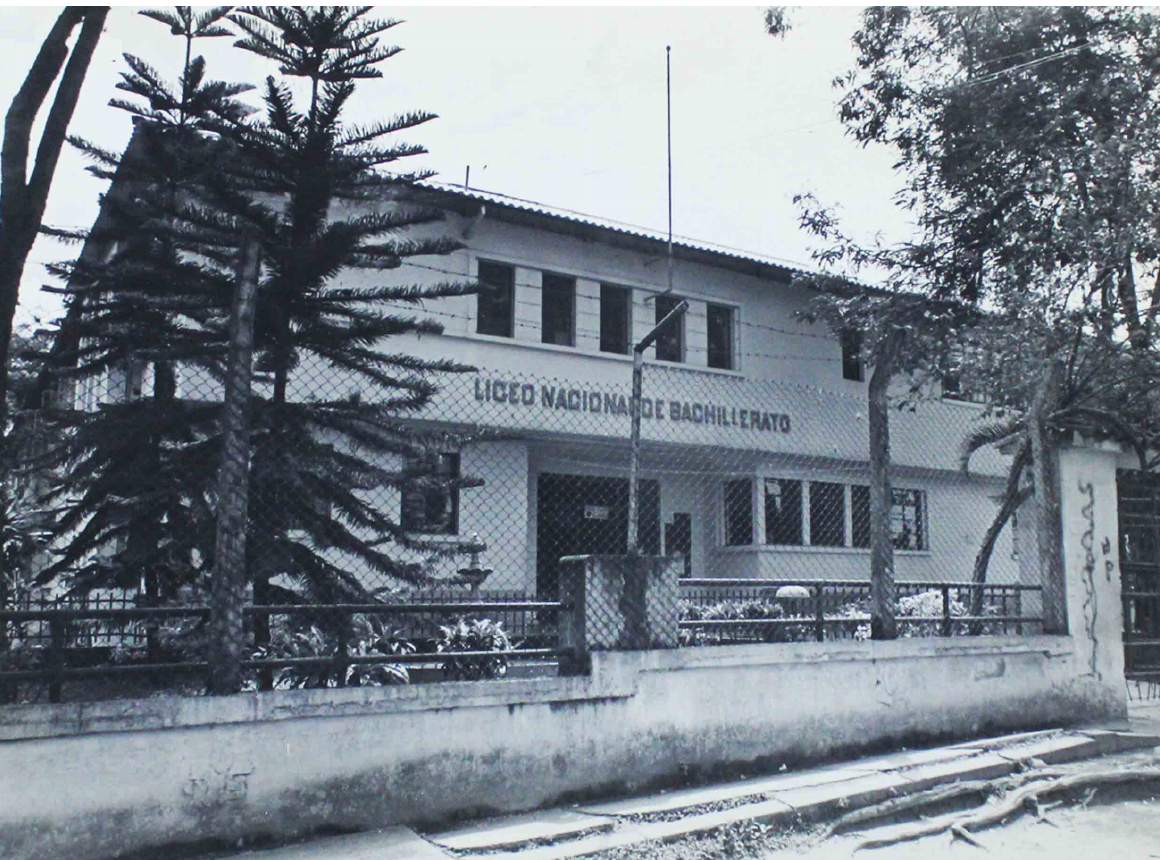
Figure 7. Female Normal School. Renamed National Lyceum in 1971. Photo by David Oviedo (1992). Source: Visual Memory File of Library Darío Echandía of Bank of Republic. Topographic number: